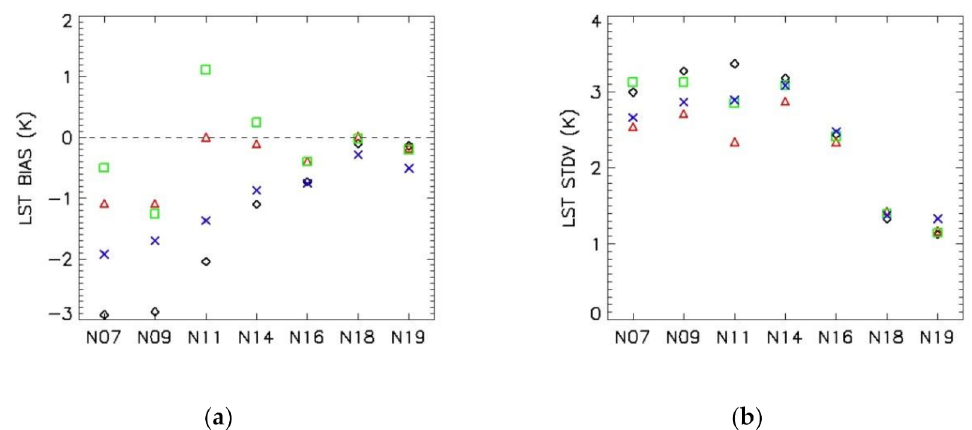
Figure 8. Bias ( a ) and standard deviation ( b ) values averaged over each NOAA platform for the drifted time series (black diamonds) and the corrected time series C0, C1, and C2 (red triangles, green squares, and blue crosses, respectively).